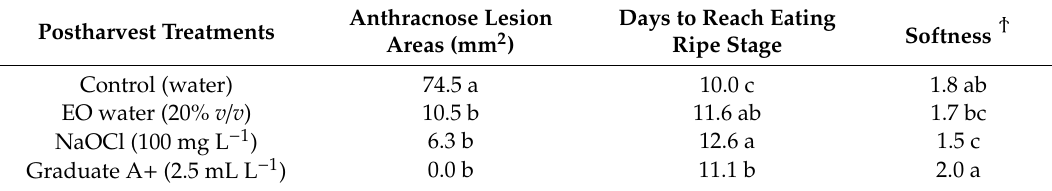
Table 4. E ff ect of electrolyzed oxidizing (EO) water and synthetic fungicide on anthracnose lesion area Table 2. Effect of electrolyzed oxidizing (EO) water and synthetic fungicides on postharvest diseases and ripening properties of avocado (cv. Wurtz) after inoculation with Colletotrichum siamense , Trial 3. and ripening properties of avocado cv. Hass, Trial 1. Anthracnose Lesion Postharvest Treatments